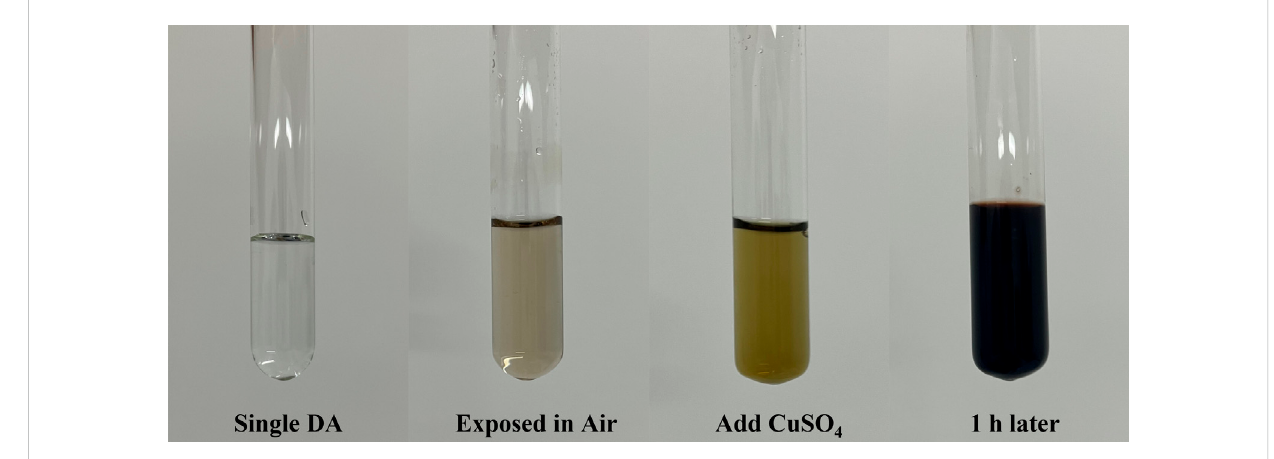
FIGURE 1 Photograph of the mixed solution under different conditions.